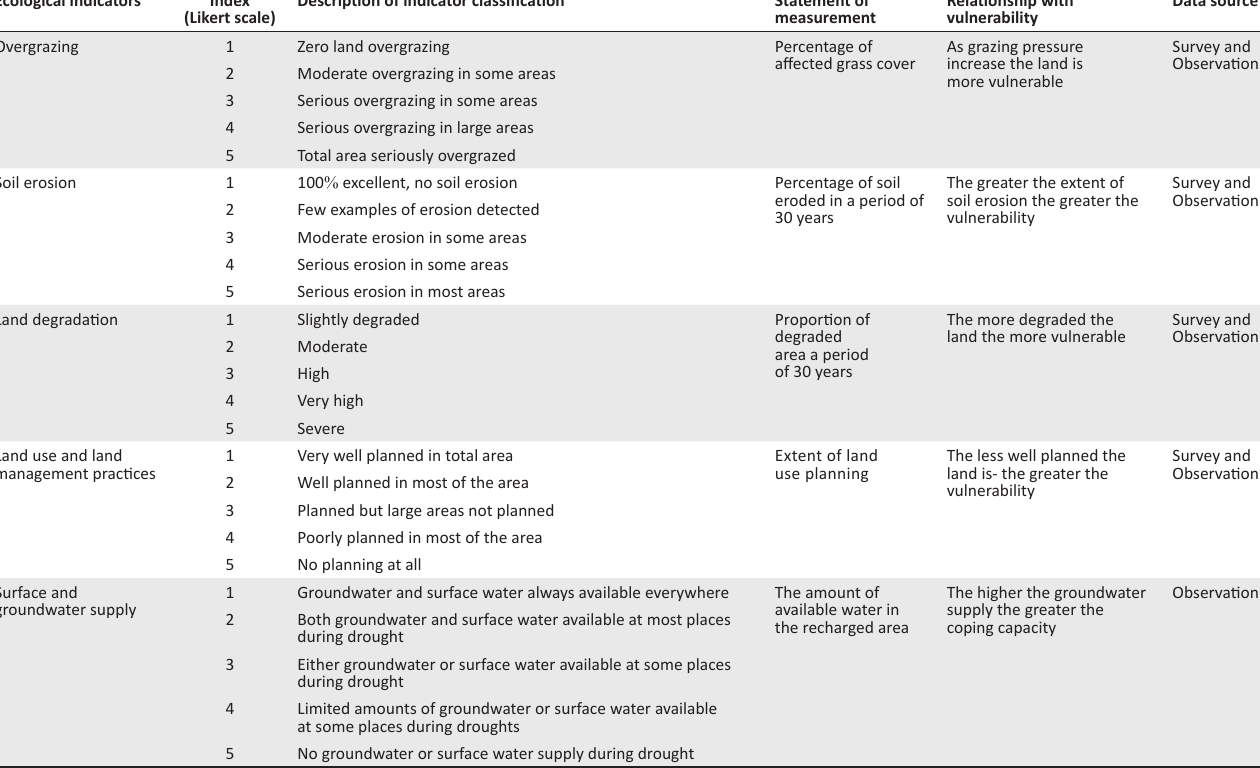
Description of indicator classification Statement of (Likert scale)